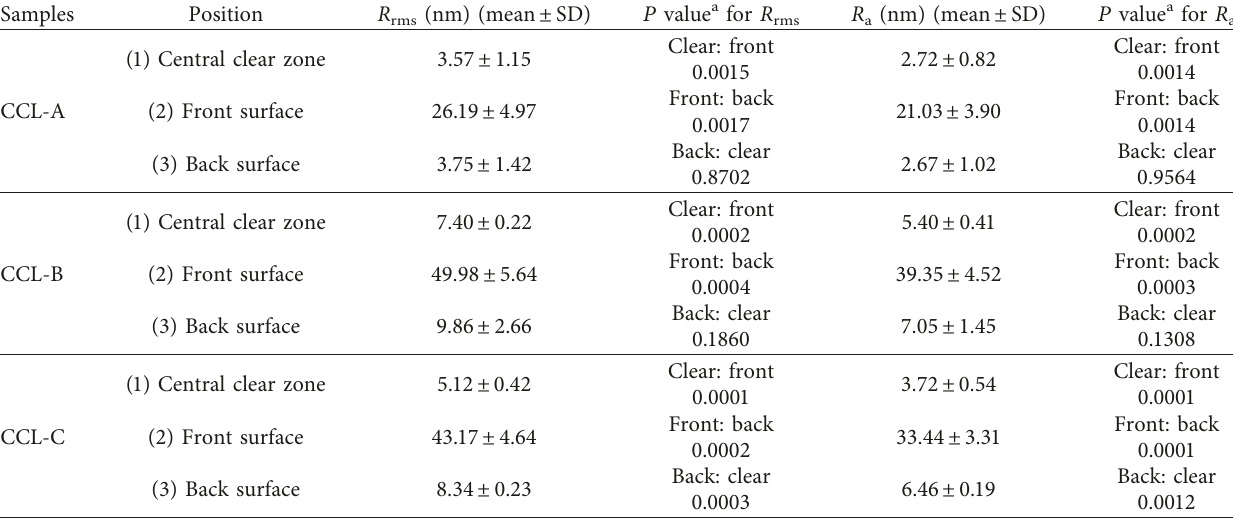
Table 2: Atomic force microscopic evaluation for root mean square roughness ( R contact lens at each area.